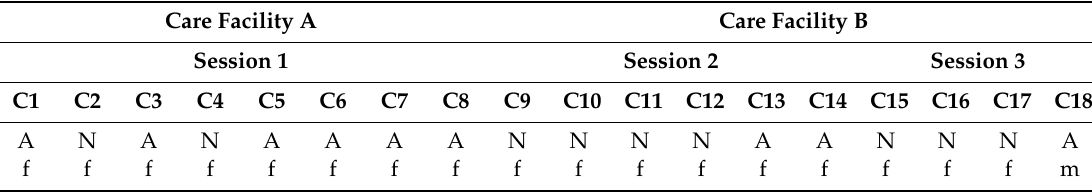
Table 2. In total, 18 professional caregivers participated in the participatory workshops, divided over three sessions organized at two di ff erent care facilities. The professional caregivers were either nursing sta ff (N) in charge of everyday care tasks or activity supervisors (A) who provide daytime activities. All caregivers were female (f), except C18